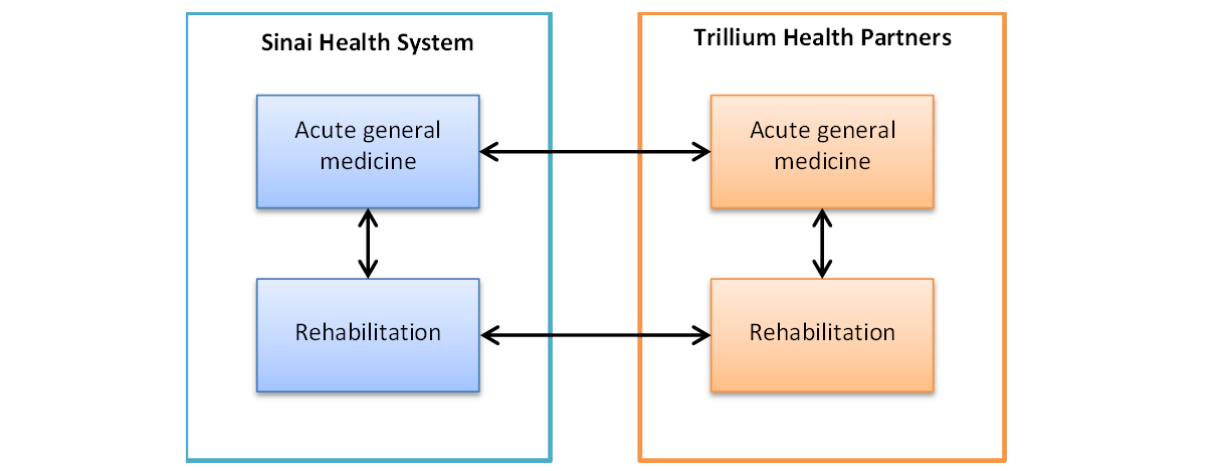
Figure 4. Within and between group pre-post